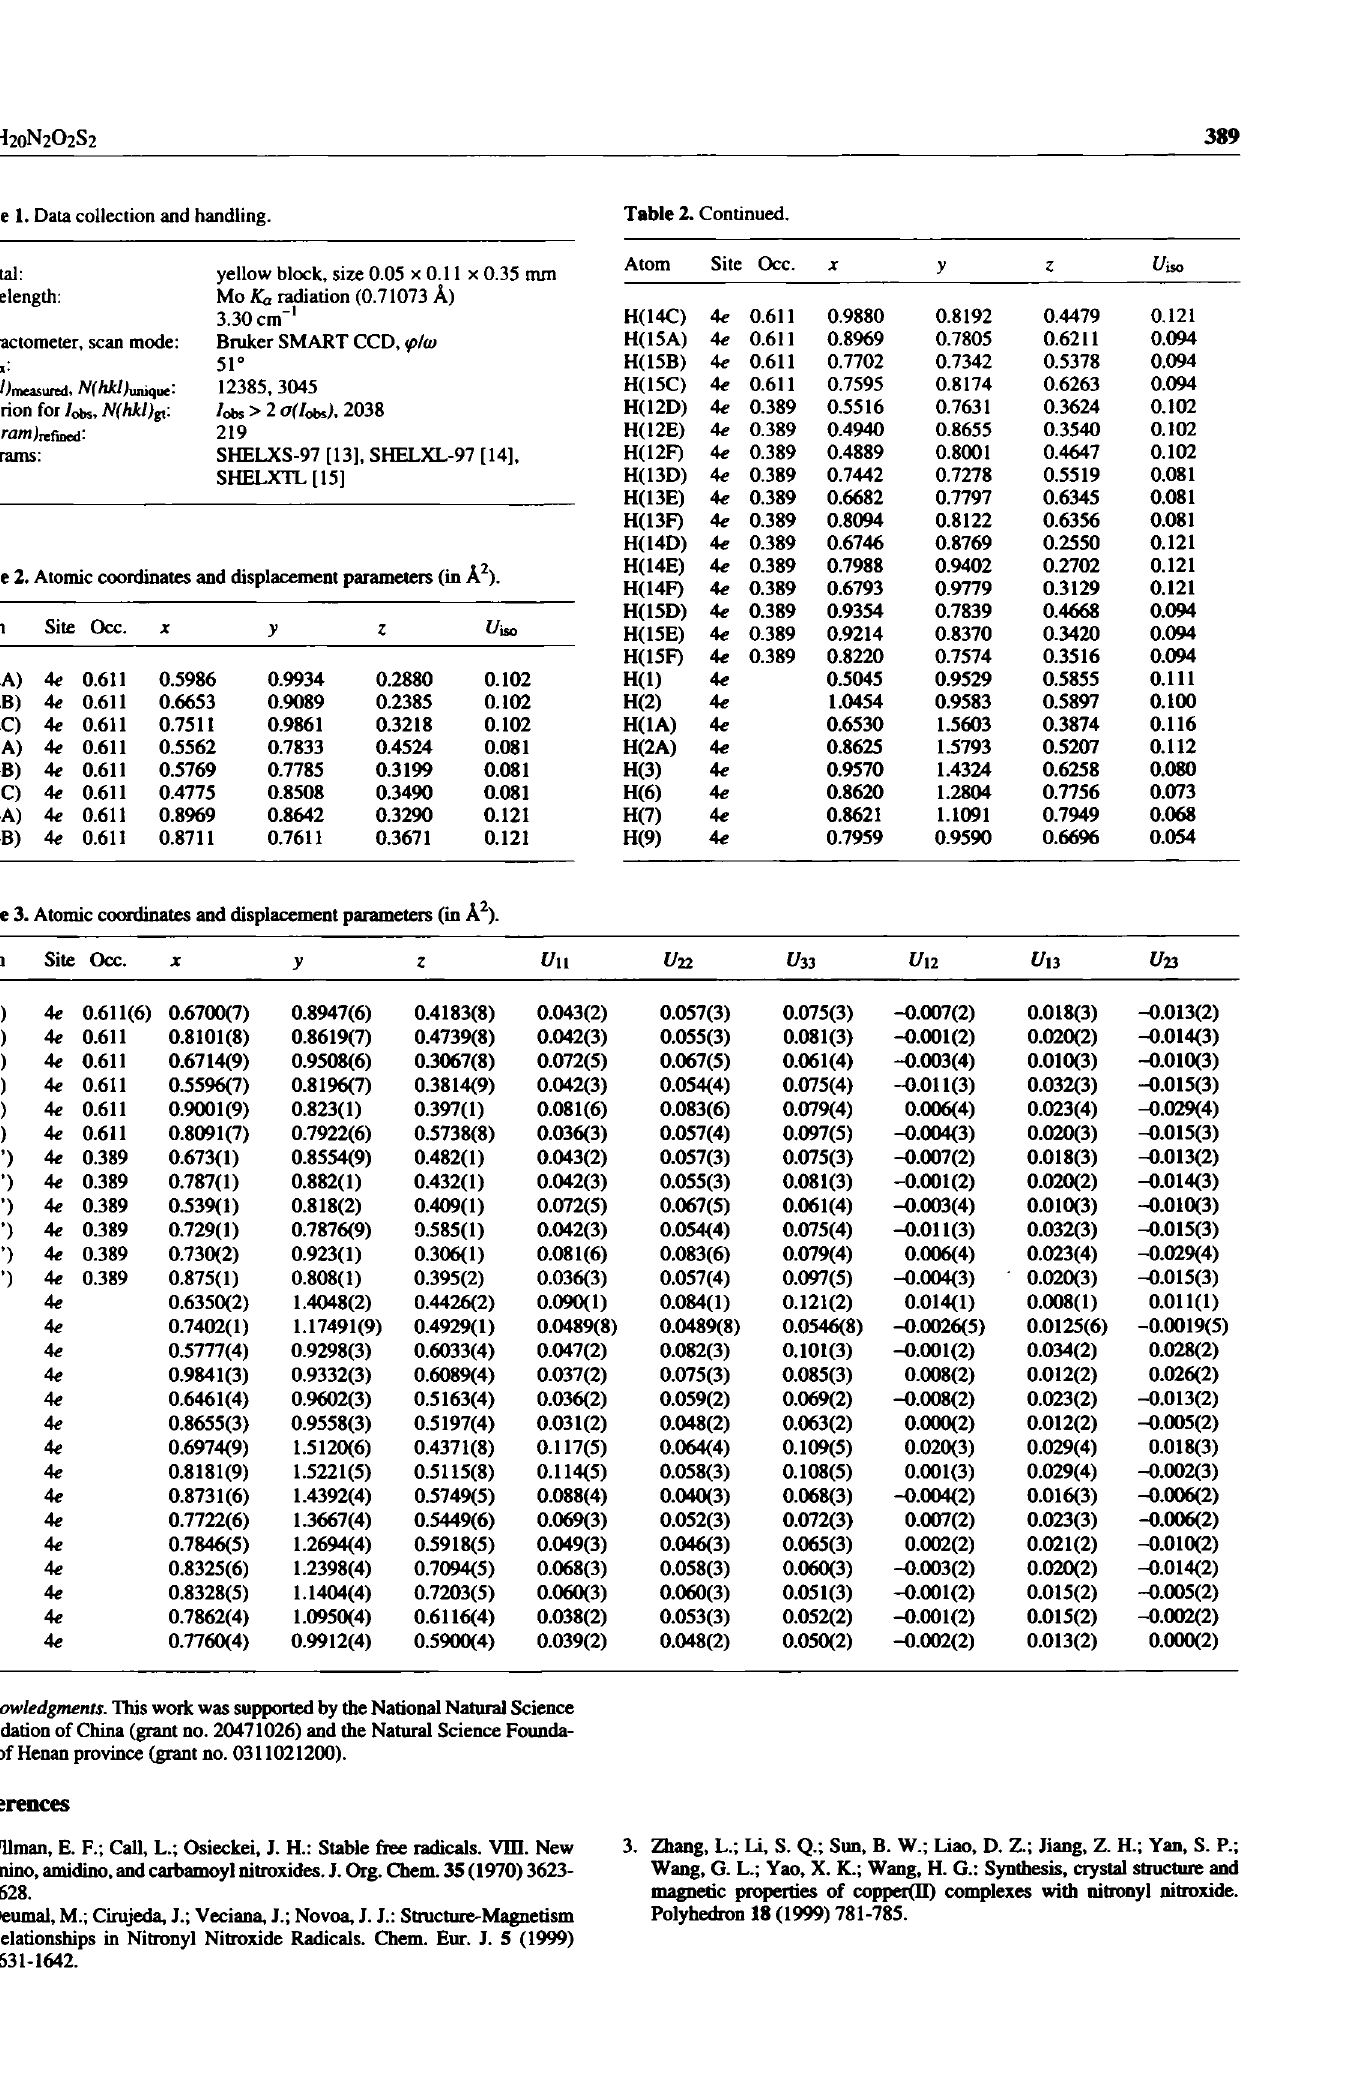
Table 2. Atomic coordinates and displacement parameters (in Â 2 ).